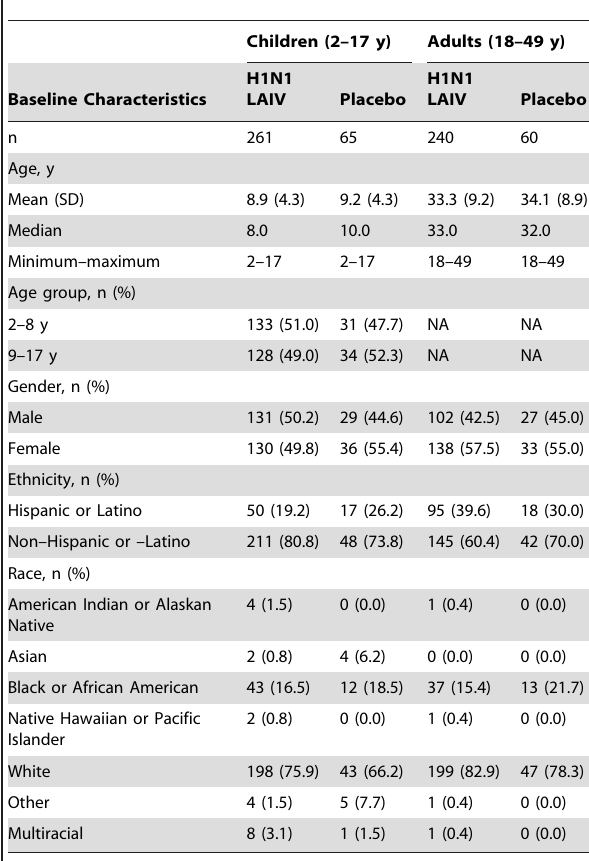
Table 1. Demographics by Treatment Group (Intent-to-Treat Population).